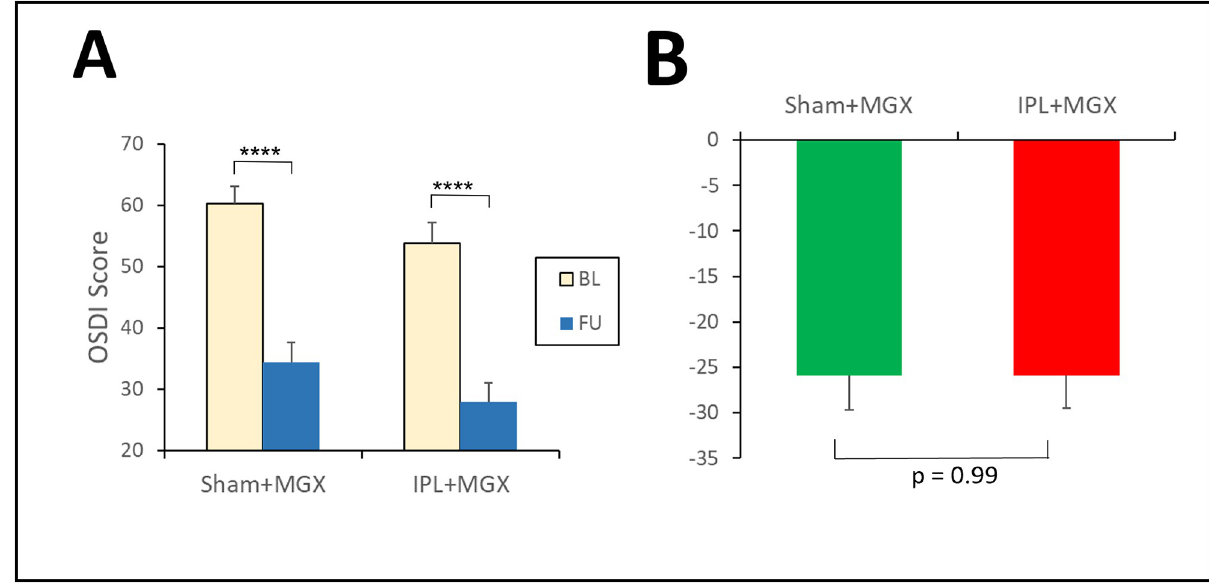
Fig 3. Change of symptoms (OSDI). A . Absolute values of OSDI; Statistical tests: 2-sided paired t-test of FU versus BL (within each arm); ���� : p < 0.0001. B . Δ TBUT; Statistical test: 2 sided least squares fit of Δ OSDI (between arms).